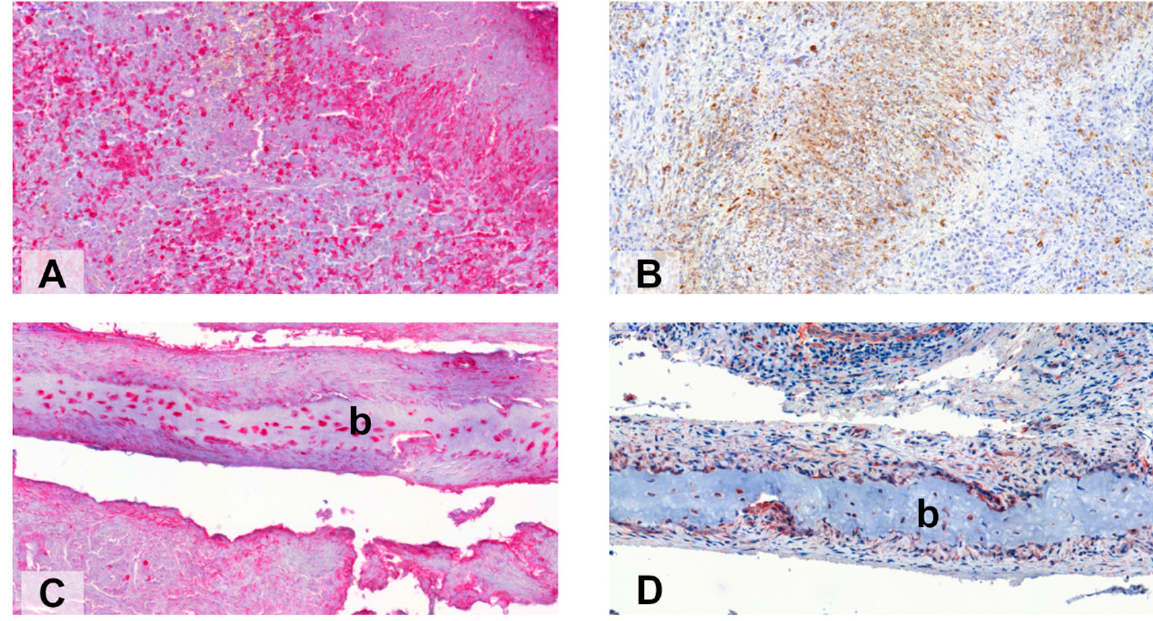
Figure 2. S100A4 + cells (red, ( A )) and CD68 + cells (brown, ( B )) in nasal tissue of GPA (serial staining), presumably palisading histiocytes, marking the edge of a granuloma. S100A4 + cells (red, ( C )) and Vimentin + cells (reddish brown, ( D )) invading bone ( b ) in nasal tissue of GPA (serial staining), presumably fibroblasts. Immunohistochemistry for S100A4 in nasal tissue of GPA ( n = 3) was performed as described previously [164]. The upper respiratory tract tissue samples of GPA were characterized in previous studies [22,76].